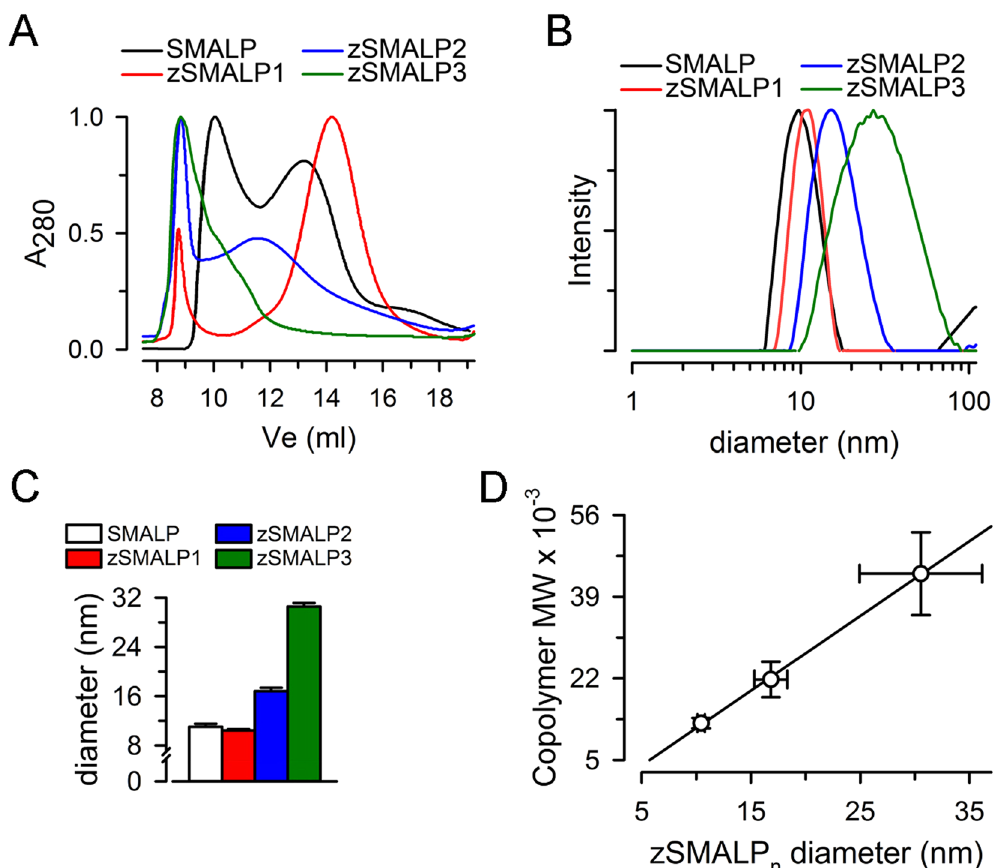
Figure 5. A comparison of nanodiscs formed by SMA and zSMAs of different sizes. ( A ) SEC. Liposomes formed by E. coli total lipids were solubilized with SMA, zSMA1, zSMA2 or zSMA3, and the solubilized material was run on a Superdex 200 Increase 10/300 GL size-exclusion column (see Methods for details). A 280 : absorbance at 280 nm. ( B ) Hydrodynamic diameter distribution. The main graph shows typical examples of different preparations illustrating the nanoparticle size distribution determined by dynamic light scattering. ( C ) Summary of hydrodynamic diameter data. Means ± SEM of experiments for nanodiscs formed by SMA (n = 4), zSMA1 (n = 6), zSMA2 (n = 5) and zSMA3 (n = 6). ( D ) Relationship between the molecular weight of the P(S- at -MA) alternating copolymers (determined by NMR, see Supplementary Table 2) and the zSMALPs diameter (determined by DLS, see panel B). Values are presented as means ± polydispersity. The line corresponds to a linear